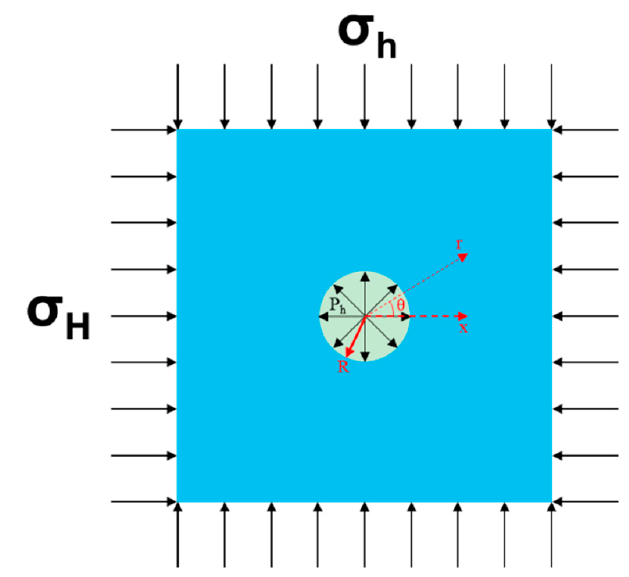
Figure 2. Stress around the ice borehole.